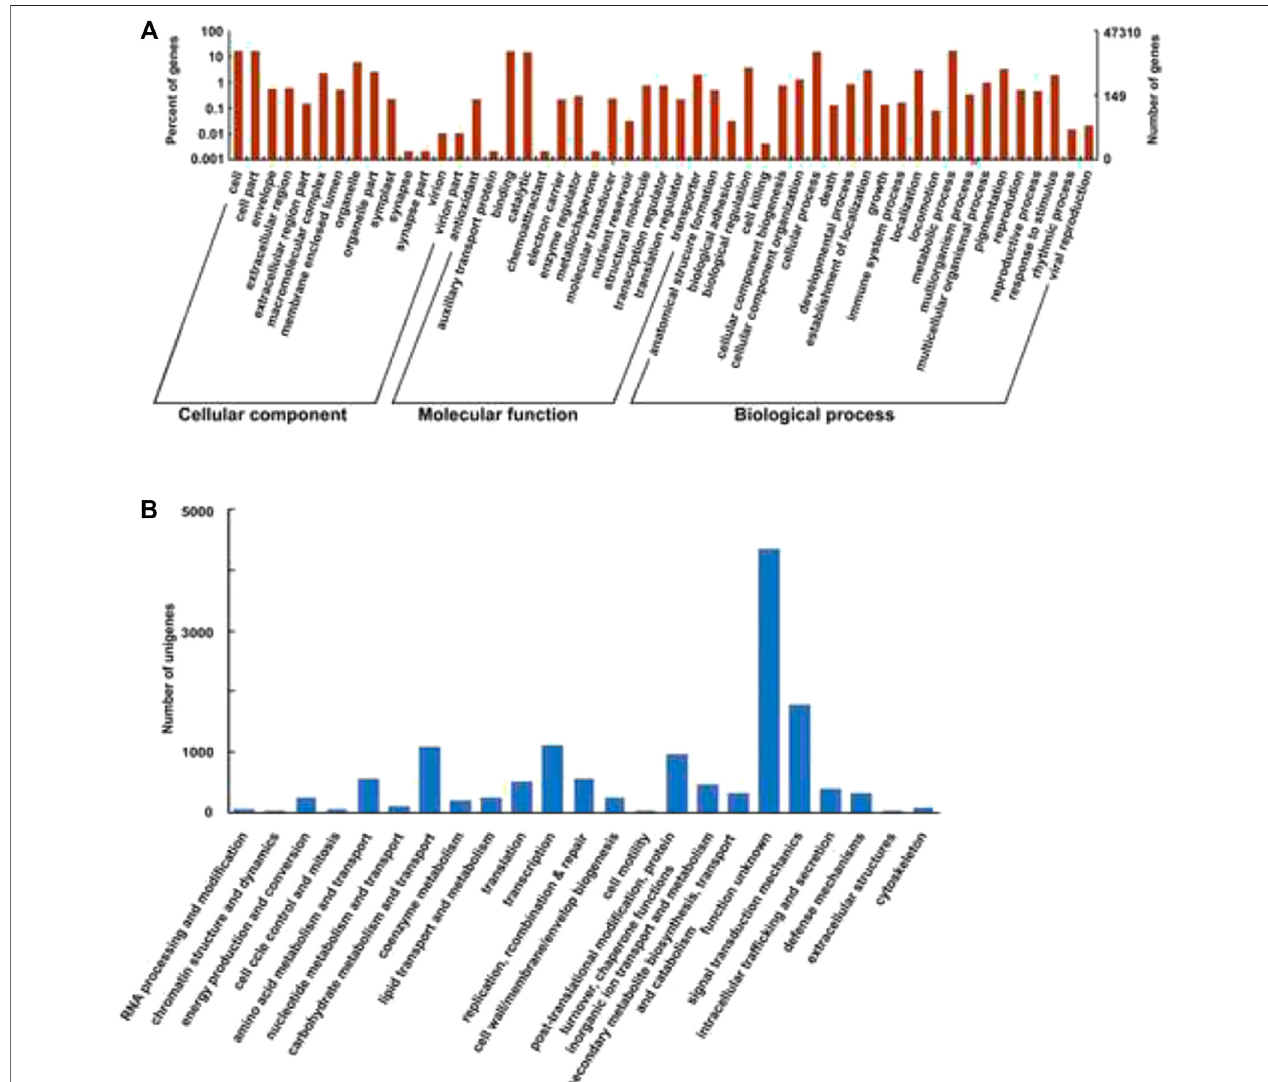
FIGURE 3 | (A) - GO (Gene Ontology) classi fi cation of the transcriptome. (B) - COGs (Clusters of Orthologous Groups) classi fi cation.